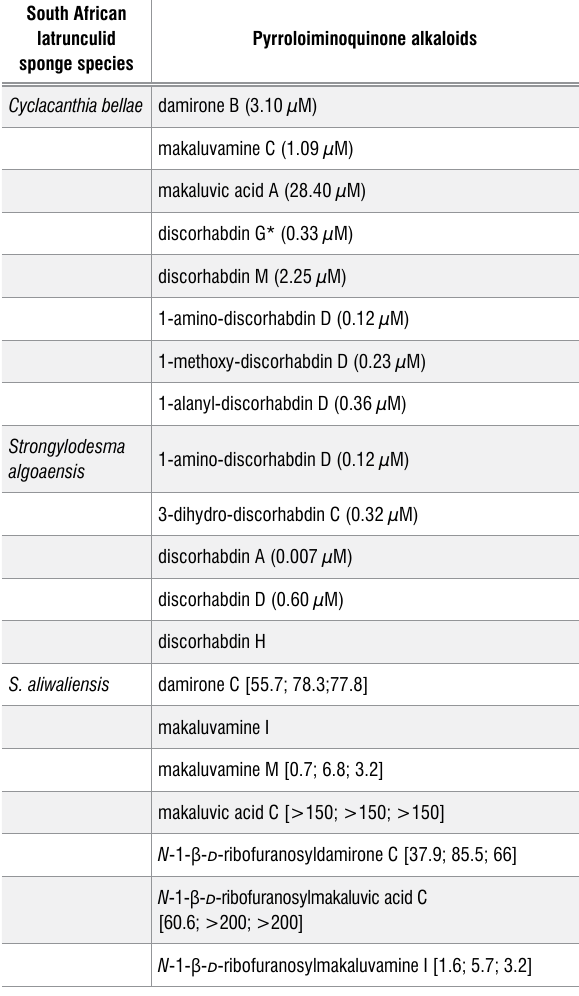
Pyrroloiminoquinone alkaloids isolated from Tsitsikamma favus and T. pedunculata . IC (µm) cytotoxicity against human colon 50 tumour cell line (HCT 116) 12 presented in parentheses. South African latrunculid sponge